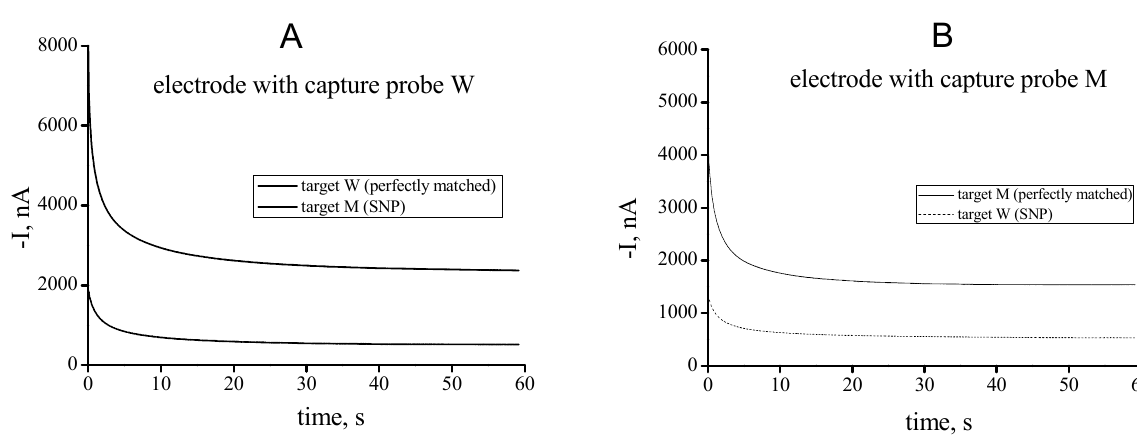
Figure 2. Optimization of the total target concentration. The DNA target sample consisted of 10% mutant DNA (T-M) and 90% wild DNA